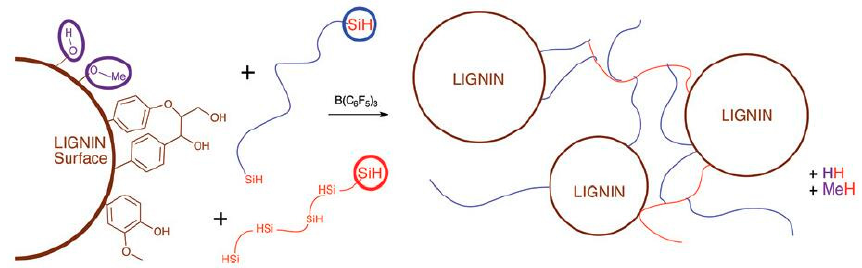
Figure 8. Scheme synthesis of lignin-silicone composites by the PR reaction [37]. Reproduced with the copyright copyright permission.